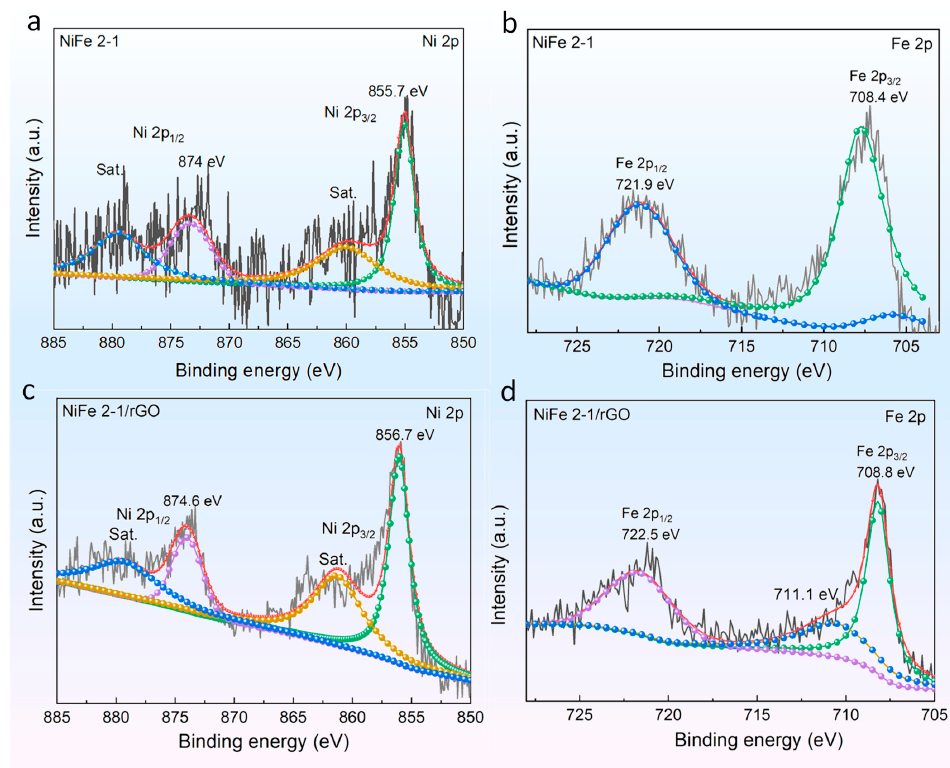
Figure 2. XPS spectra of samples before OER measurement. ( a , b ) High-resolution Ni 2p, Fe 2p, and O 1s spectra of PBA NiFe 2-1, respectively; ( c , d ) high-resolution Ni 2p, Fe 2p, and O 1s spectra of PBA NiFe 2-1, respectively.